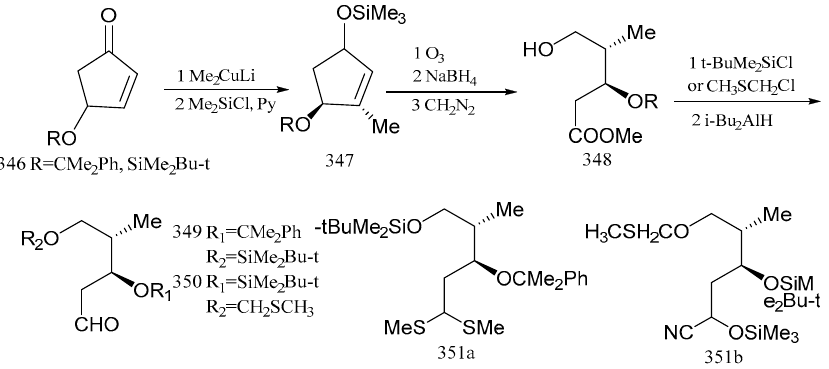
Figure 19. Compounds synthesized from the ( S )-(+)-4-hydroxy-2-cyclopentenone derivative of maytansine.